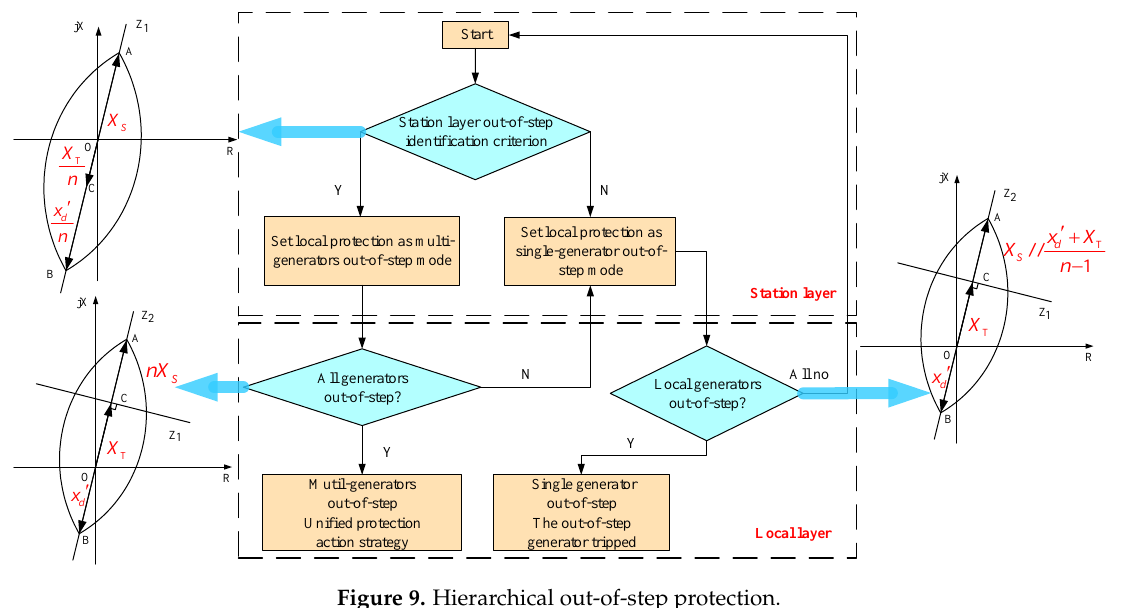
Figure 9. Hierarchical out-of-step protection.